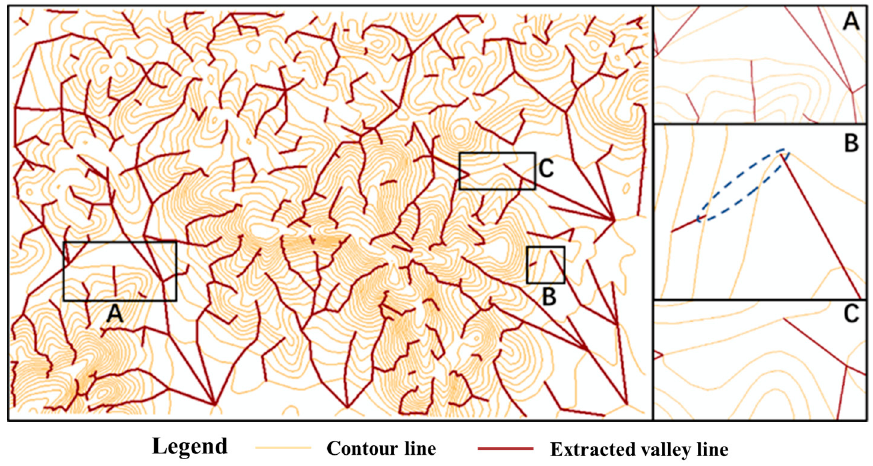
Figure 12. Valley line extraction results from the method proposed by Zhang et al. [19].